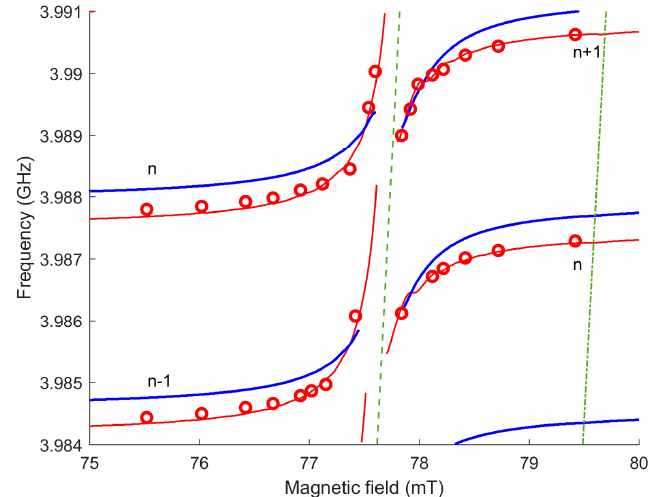
Figure 5. Magnetic field dependencies of resonance frequencies for device 1. The circles indicate the positions of the resonances in the experimental data from Figure 4a; red lines—approximation of these data by a model with two 15 µm YIG layers; blue lines—the result of the calculation of the model with only one YIG layer of 30 µm; the green dotted line is the MER line; the green dash-dotted line is the FMR line. The calculations were performed for D = 4.5 × 10 − 14 mT·m 2 . The blue curves show the simulation results for the structure with the same D tot and Φ , but with only one double thickness YIG layer on the opposite side from the transducer.